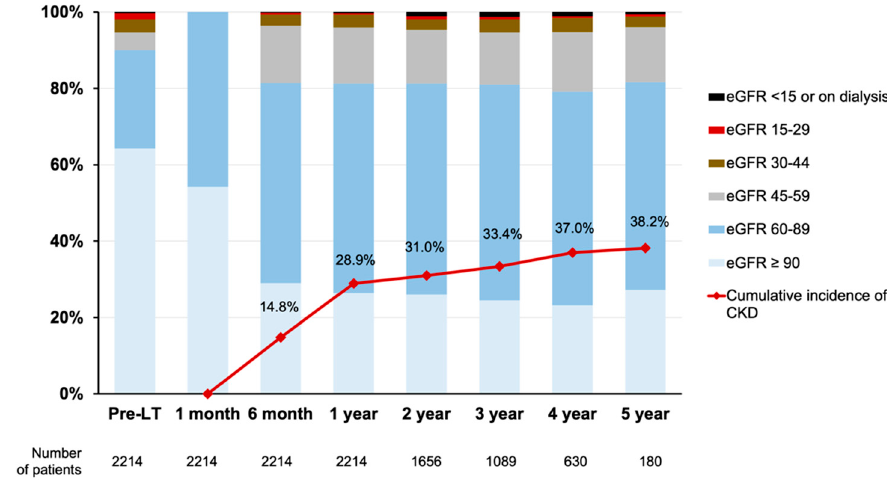
Figure 2. Distribution of eGFRs at specific time points and cumulative incidences of CKD. CKD was defined as eGFR < 60 mL/min/1.73 m 2 , receiving dialysis or kidney transplantation. CKD, chronic kidney disease; eGFR, estimated glomerular filtration rate; LT, liver transplantation.